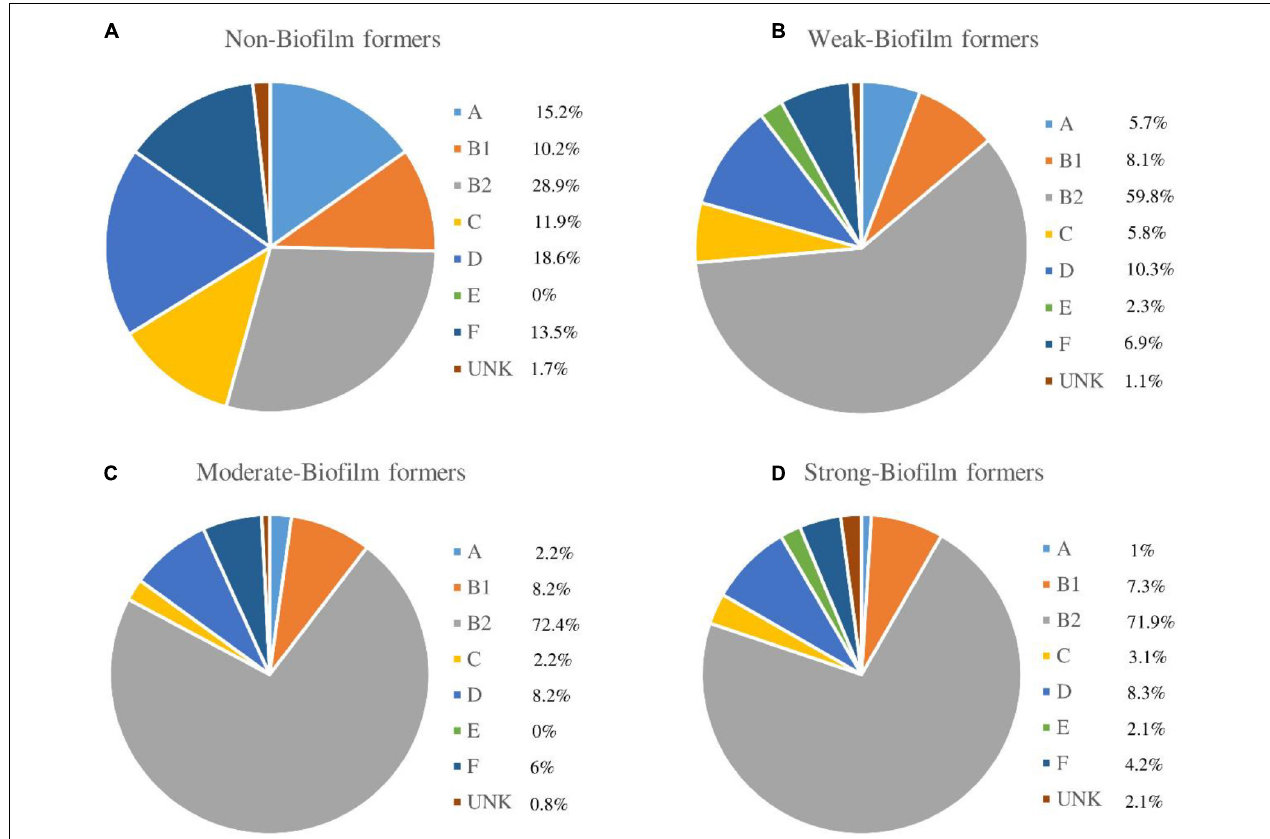
FIGURE 6 | Phylogroup assignment according to the biofilm formation. UNK: Unknown. (A) Non-Biofilm former strains. (B) Weak-Biofilm former strains. (C) Moderate-Biofilm former strains. (D) Strong-Biofilm former strains.